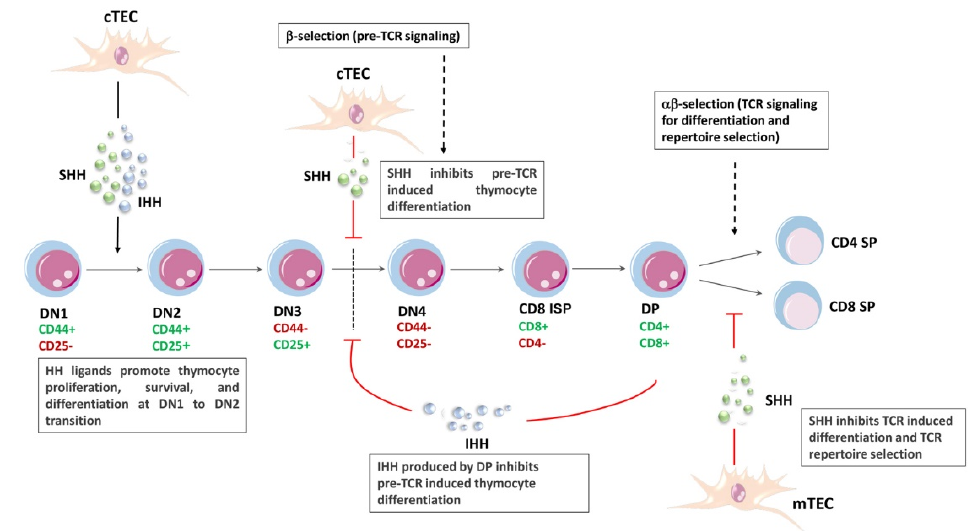
Figure 3. Multiple stages of thymocyte differentiation are controlled by HH signaling. The schematic cartoon illustrates how HH signaling influences several stages of thymocyte development in the mouse embryonic thymus. cTECs, cortical thymic epithelial cells; IHH, Indian hedgehog; ISP, immature single positive; mTECs, medullary thymic epithelial cells; SHH, Sonic hedgehog; TCR, T-cell receptor.